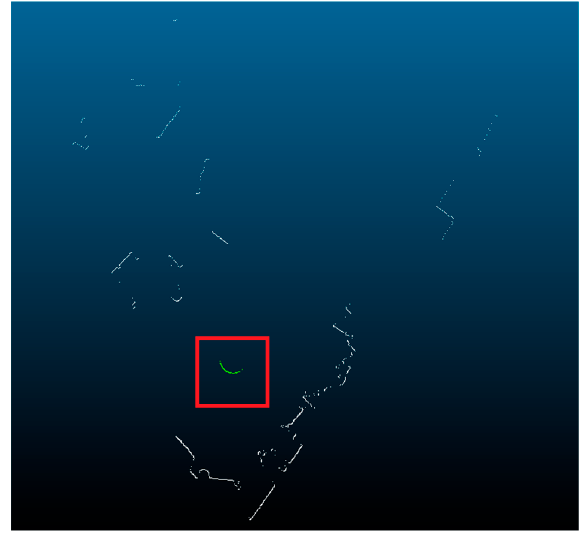
Figure 2. Point cloud filtering preprocessing. The red box is the filtering interval, and the white points represent the point cloud before filtering, while the green points represent the point cloud after filtering.